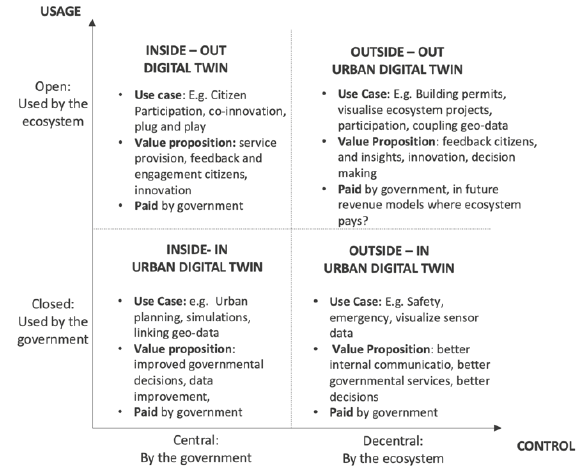
Figure 2. Value proposition Urban Digital Twins